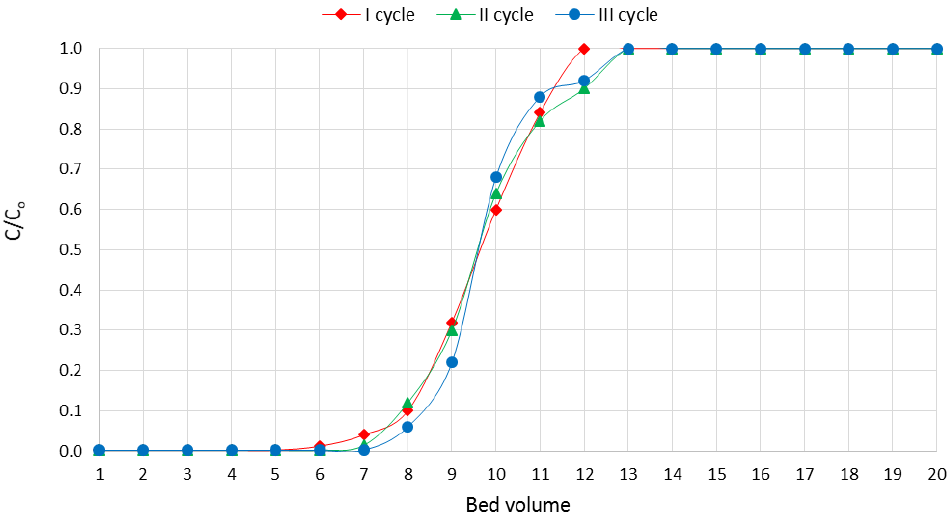
Figure 5. Characteristics of CT169 during sorption.